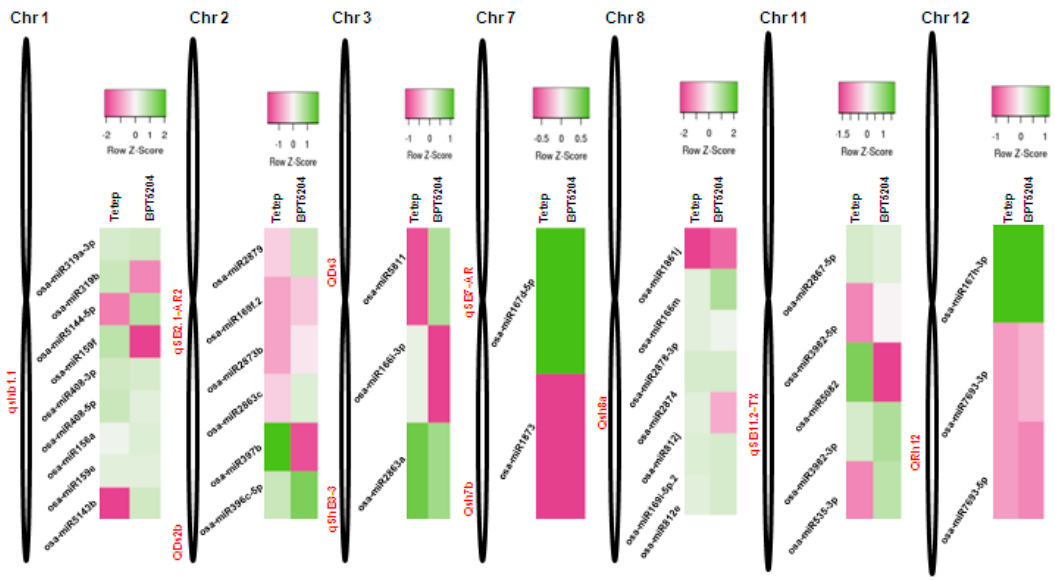
Figure 8. Mapping of R . solani -induced miRNAs to QTL regions conferring resistance to sheath blight disease. Heat map of these miRNAs expression in tolerant (Tetep) and susceptible (BPT5204) genotypes under the fungal infection is also shown.